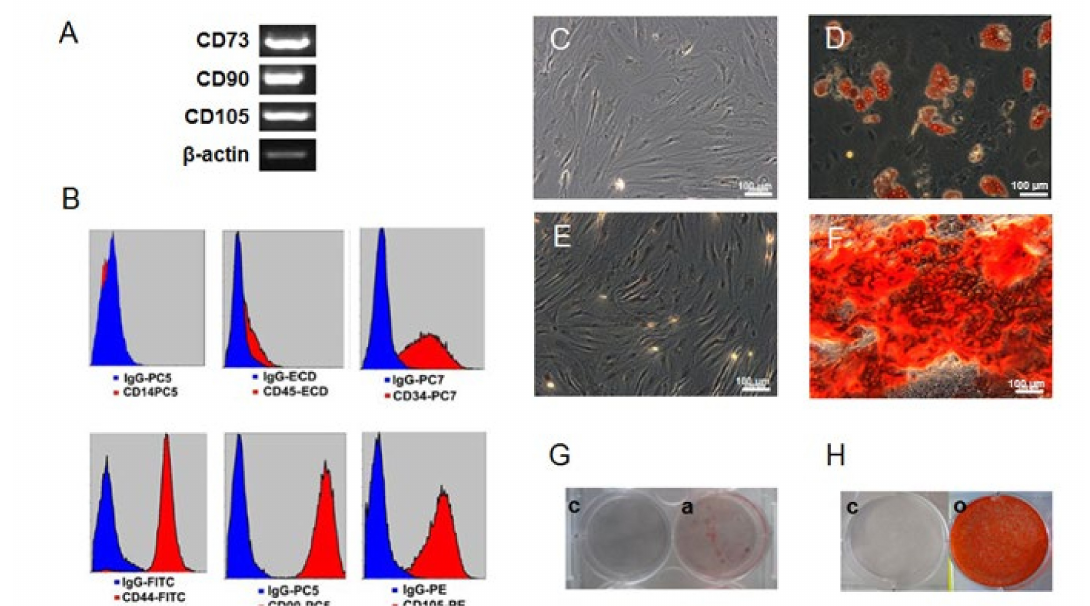
Figure 1. Verification of mesenchymal stem cell character. Isolated cells were positive for CD44, CD73, CD90 and CD105 and negative for CD14, CD45 by RT-PCR ( A ) and flow cytometry ( B ). Interestingly, these cells partially expressed CD34. Adipogenic di ff erentiation was evaluated by Oil Red O staining of undi ff erentiated ( C ) and adipogenic di ff erentiated cells ( D ). The di ff erence was also visible from petri-dish ( G ). Mineralization during osteogenic di ff erentiation was performed by Alizarin Red S staining of un-di ff erentiated ( E ) and osteogenic di ff erentiated cells ( F ). The di ff erence was also compared between petri dish grown cultures ( H ). Human mesenchymal stem cells (hMSC) markers and specific stainings were chosen in accordance with the International Society for Cellular Therapy [19]. β -actin served as internal control. Each picture represents one donor out of 3; each yielded similar